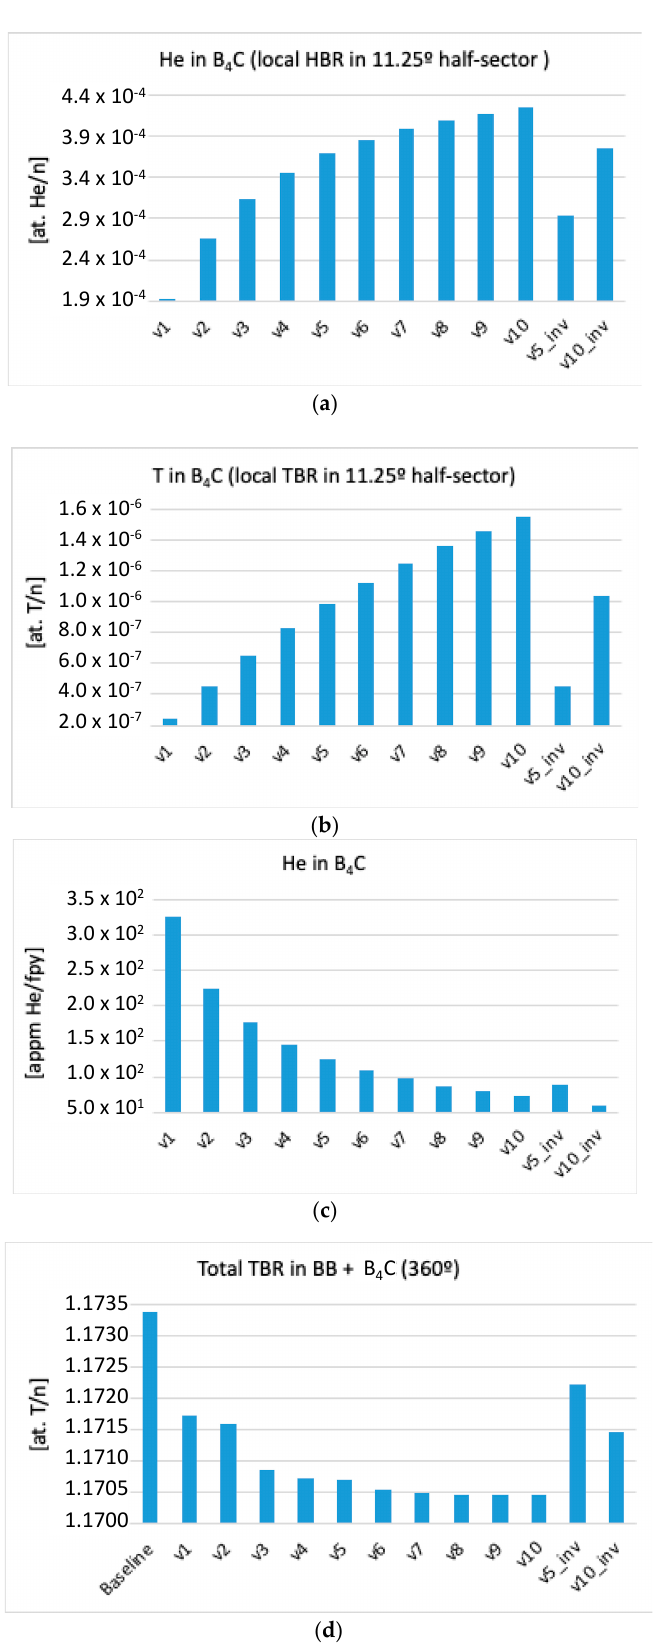
Figure 8. He and T production for the baseline model, the 10 modified versions, and inverted versions v5 and v10 as at. He/n ( a ), at. T/n ( b ), appm He/FPY ( c ) and total TBR ( d ).